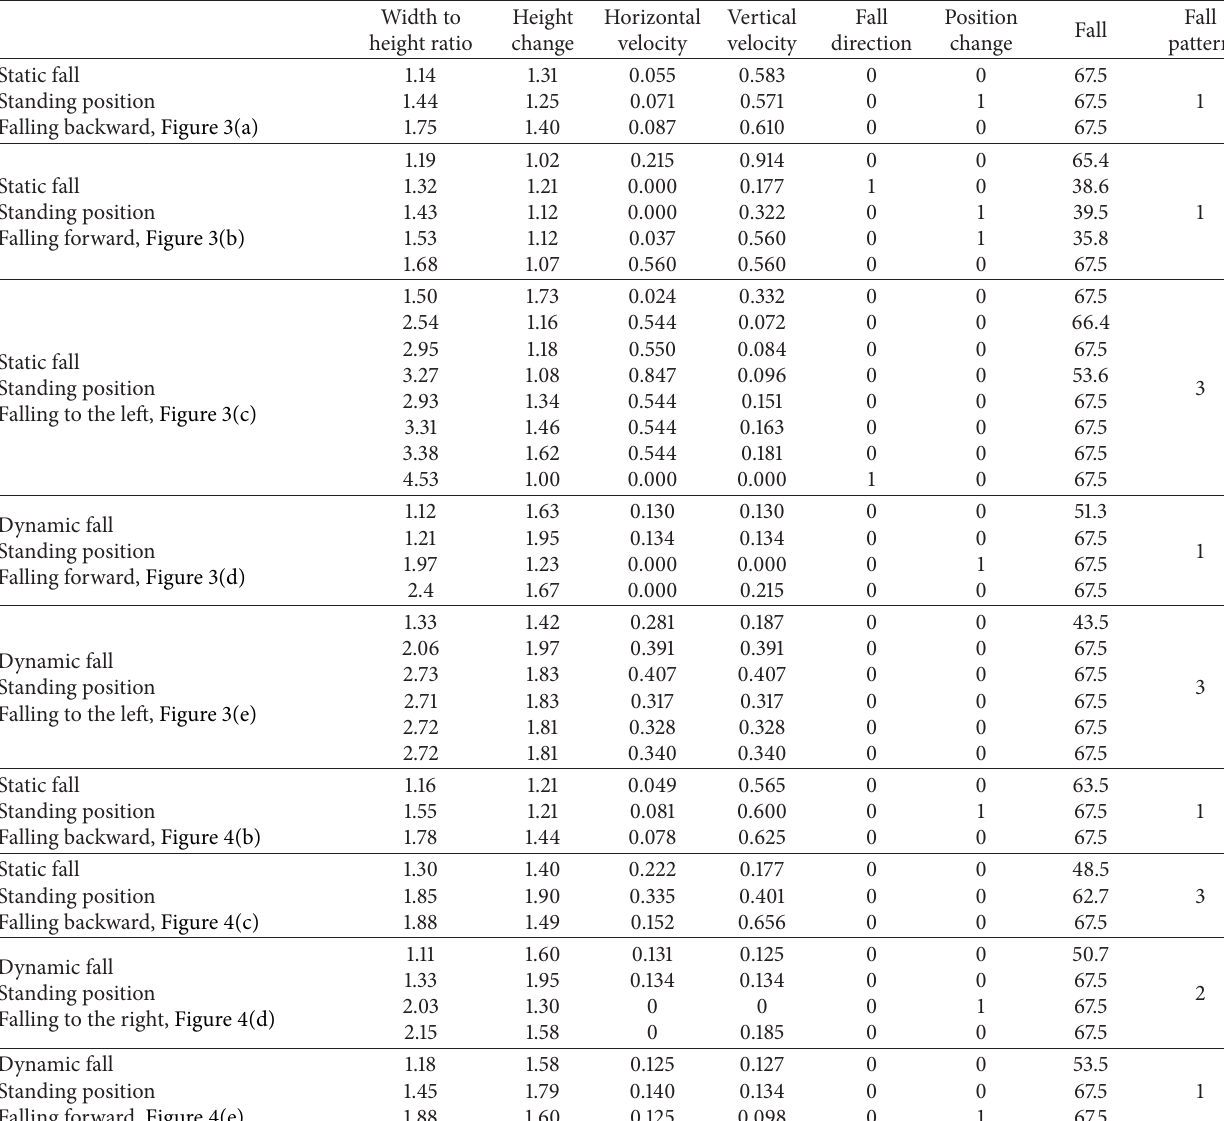
Table 1: Results of fall detection and fall pattern recognition from a “standing” position in infrared and